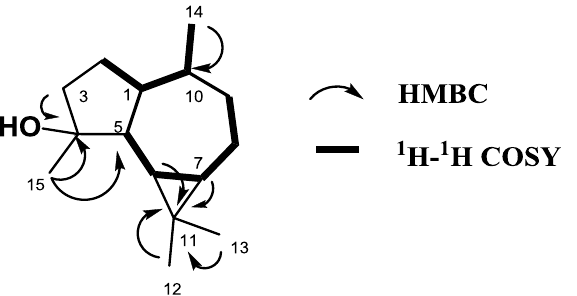
Figure 2. Selected 1 H- 1 H Corelated Spectroscopy (COSY) and Heteronuclear Multiple Bond Correlation (HMBC) correlations for 1 .